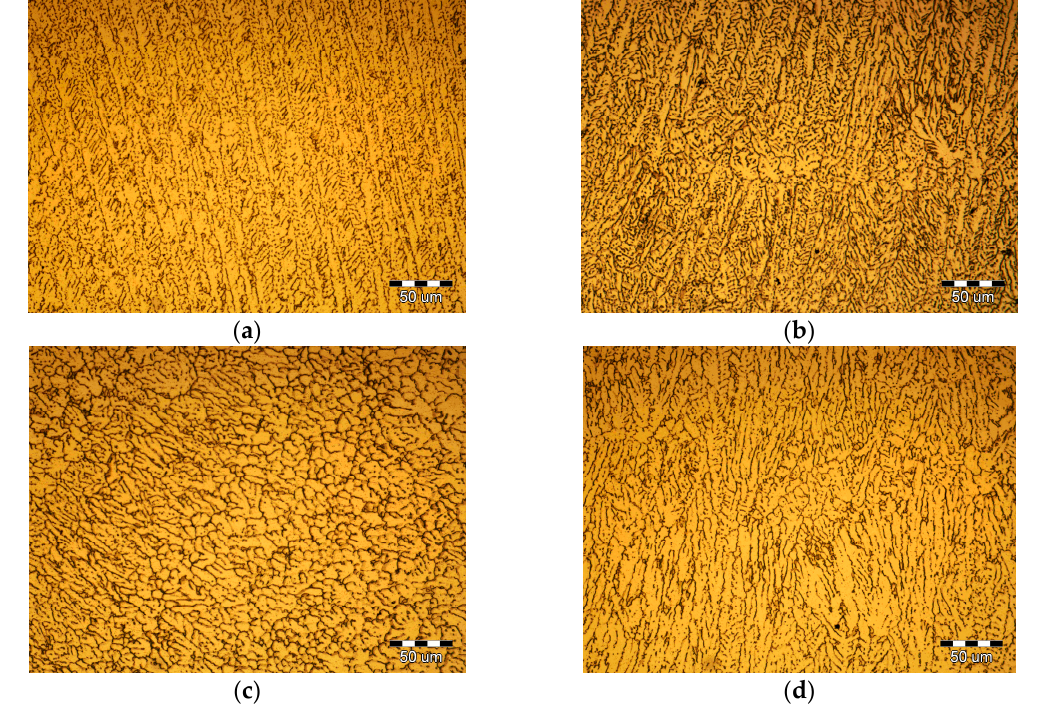
Figure 8. Effect of peak current I 0 on the PCALW weld microstructure for: ( a ) I 0 = 0 (autogenous laser welding); ( b ) I 0 = 4 kA; ( c ) I 0 = 6 kA; and ( d ) I 0 = 8 kA.